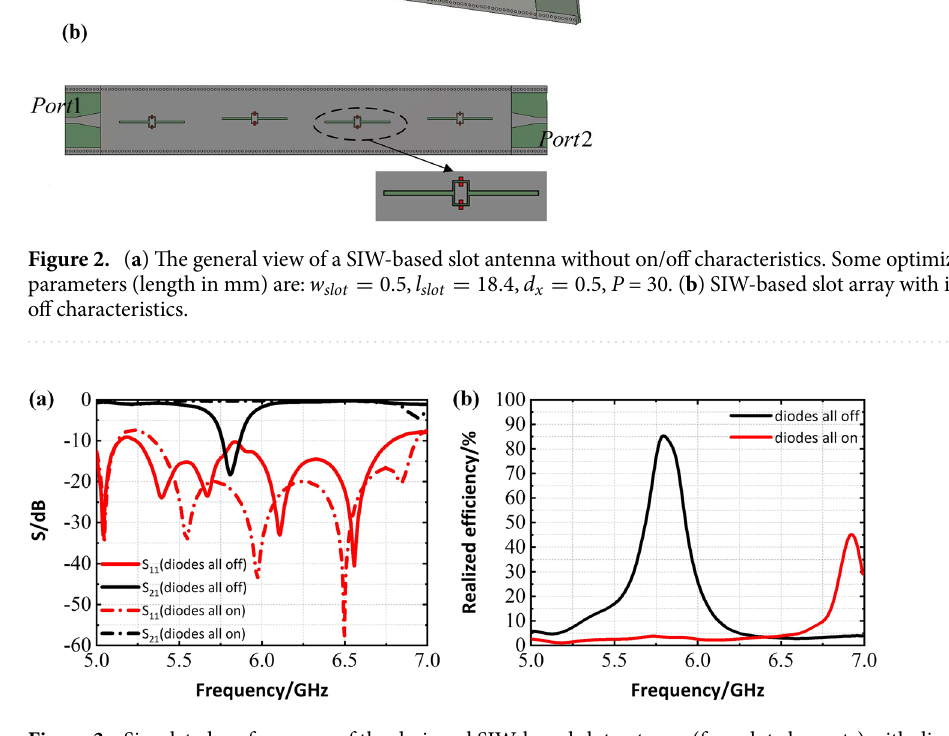
Figure 3. Simulated performance of the designed SIW-based slot antenna (four slot elements) with diodes (All on means diodes are in the on state, all off indicates the opposite) ( a ) Scattering parameters. ( b ) Realized radiation